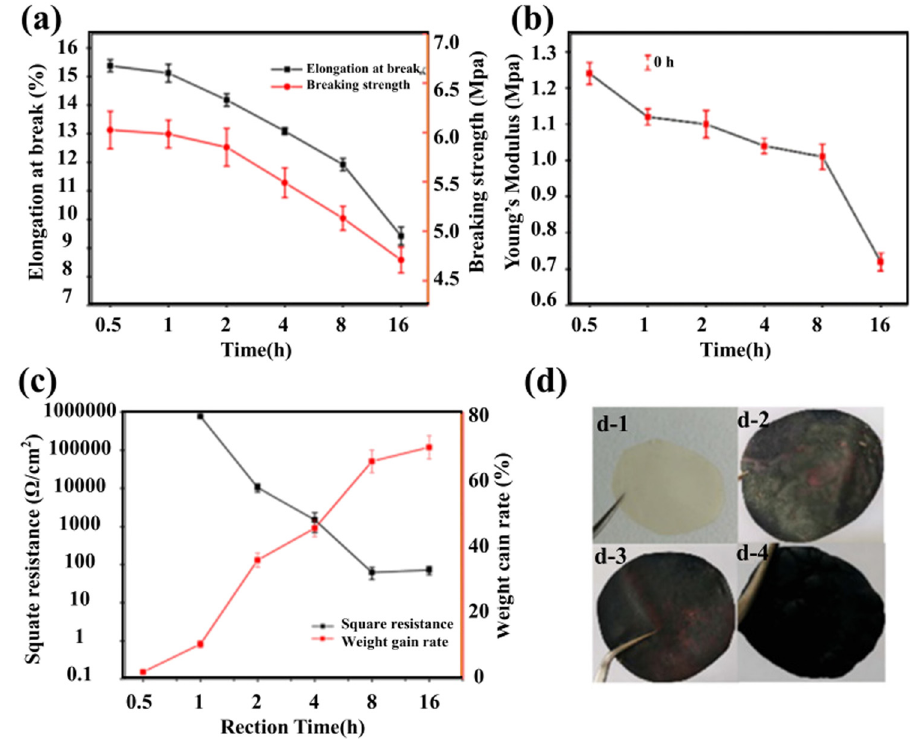
Figure 5: Mechanical properties of SF/PEDOT membrane. ( a ) E ff ect of reaction time on breaking strength and elongation at break, ( b ) Young ’ s modulus, ( c ) square resistance and weight gain. ( d ) The appearance color of the SF fi lm, Pure SF fi lm ( d - 1 ) and SF/PEDOT membrane with reaction time of ( d - 2 ) 0 h, ( d - 3 ) 0.5 h, and ( d - 4 ) 8